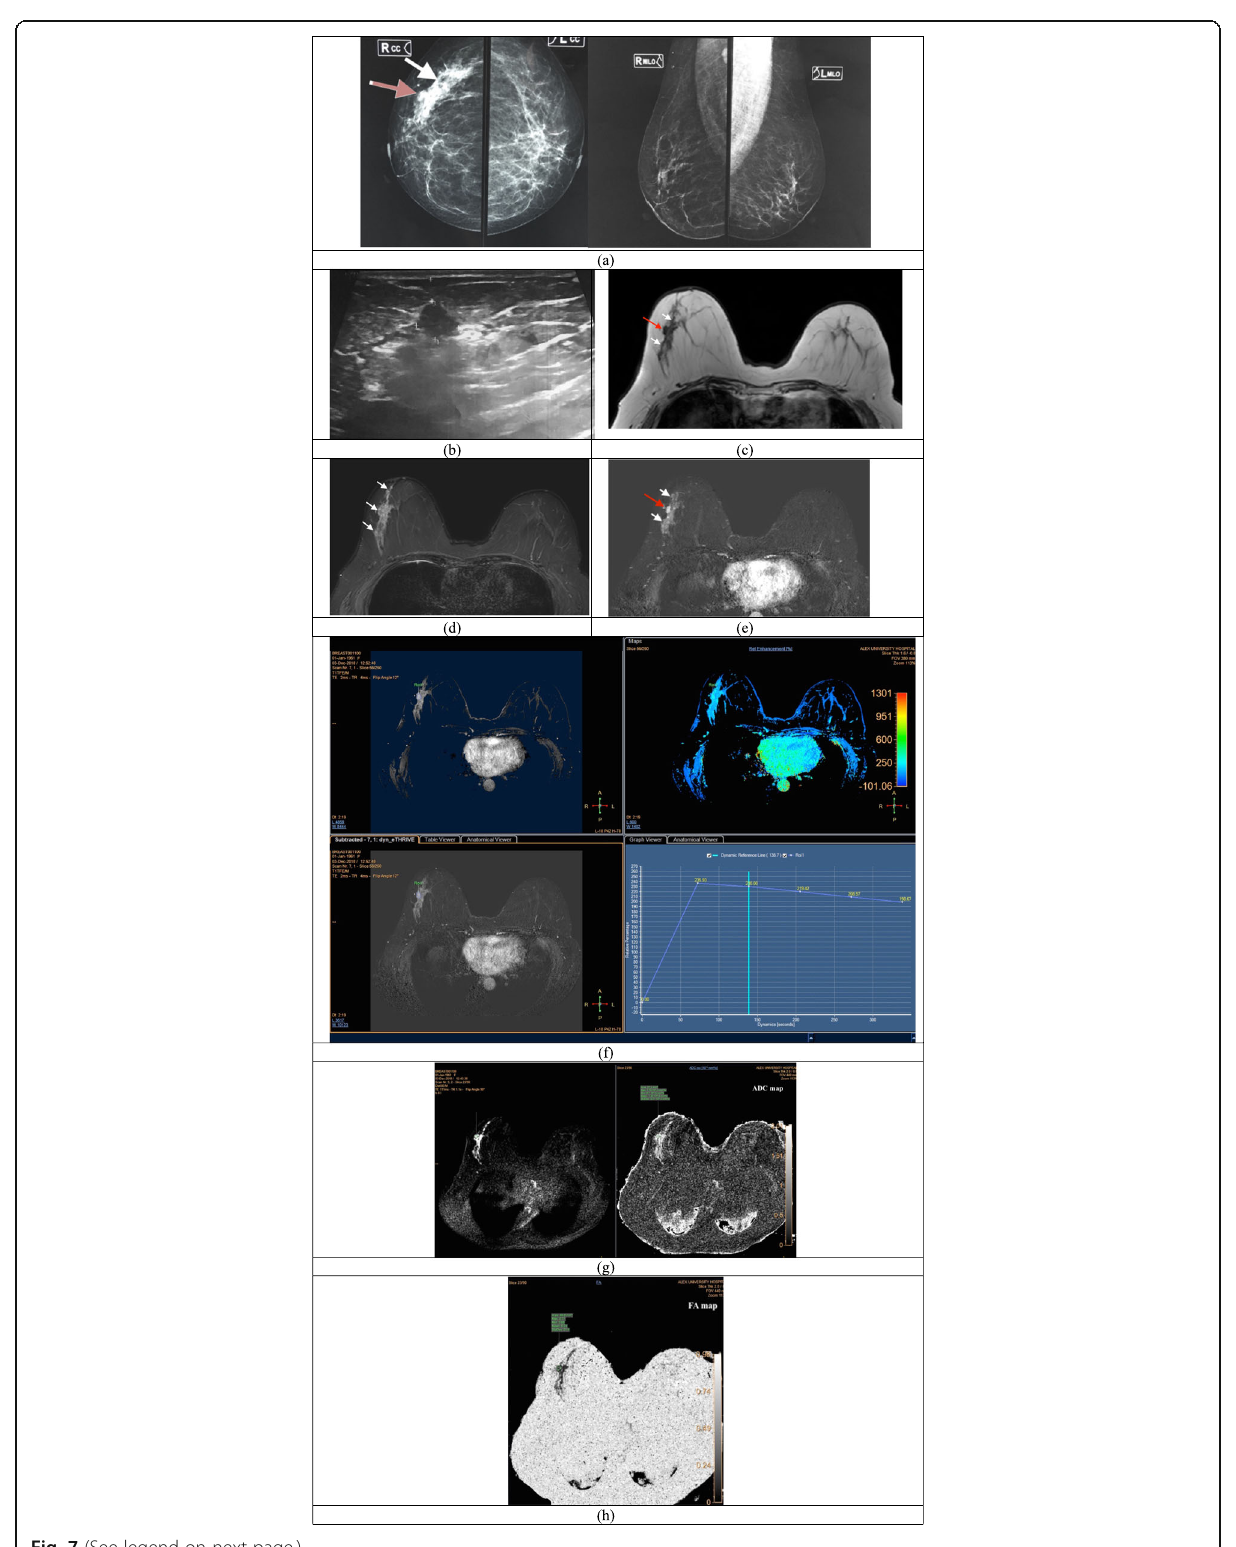
Fig. 7 (See legend on next